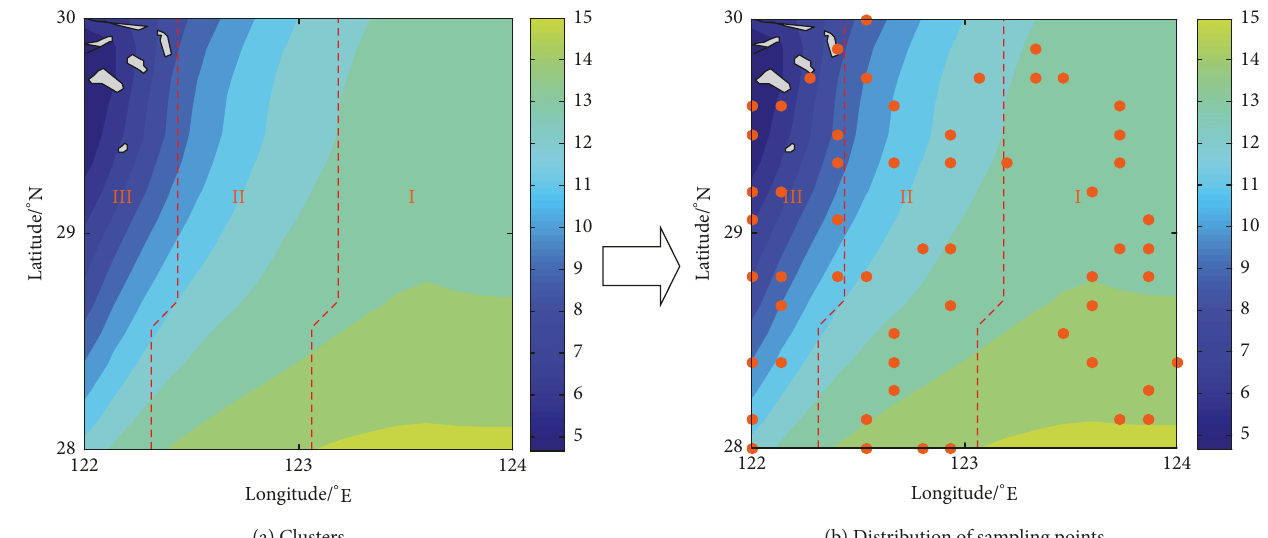
Figure 4: Configuration of sampling